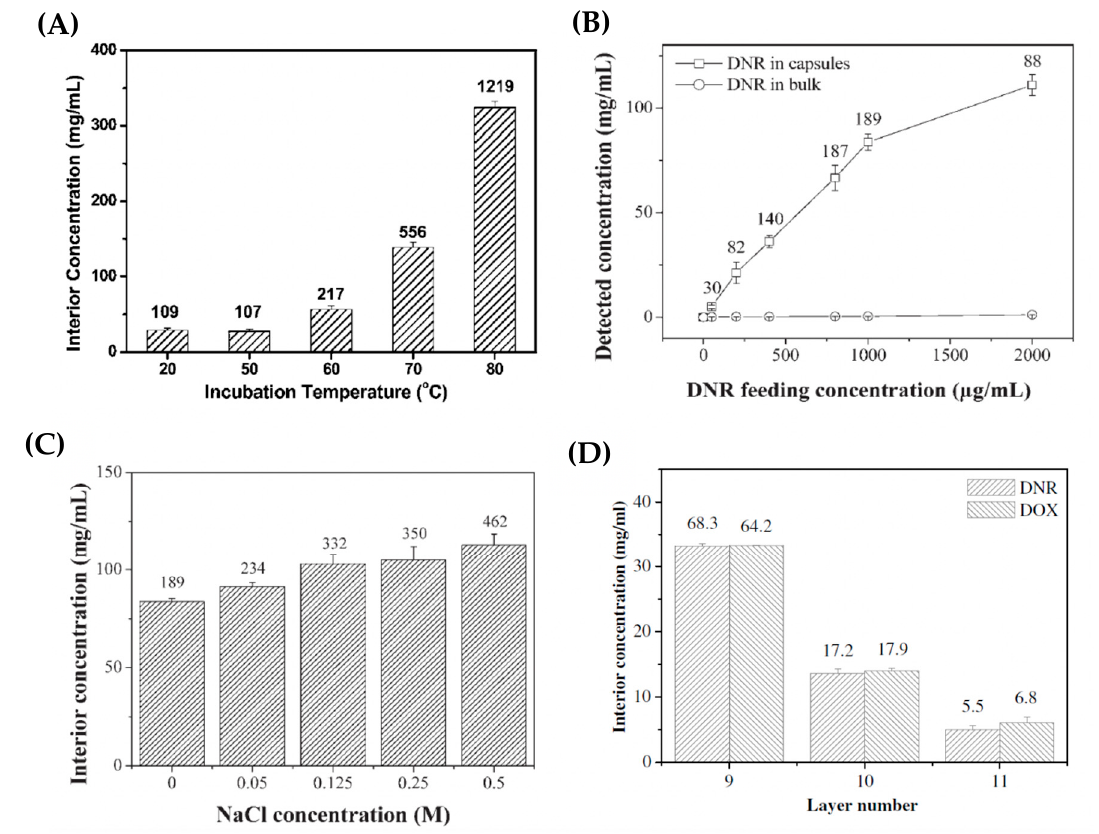
Figure 4. ( A ) The effect of incubation temperature upon DOX uptake into (PSS/PDADMAC) 5 capsules; ( B ) the effect of the DNR feeding concentration upon the uptake into ALG)/CS)-based capsules; ( C ) the effect of ionic strength (NaCl concentration) upon the loading of DNR into ALG/CS-based capsules; and ( D ) the effect of the number of layers upon the uptake of both DOX and DNR within poly(allylamine hydrochloride) (PAH)/PSS-based capsules. The values embedded in the figures represent the concentration ratios between the capsule interiors and the bulk. Figure A taken with permission from Reference [76], copyright© 2011, Royal Society of Chemistry. Figures B and C taken with permission from Reference [92], copyright© 2007, John Wiley and Sons. Figure D taken with permission from Reference [93], copyright© 2006, Elsevier.